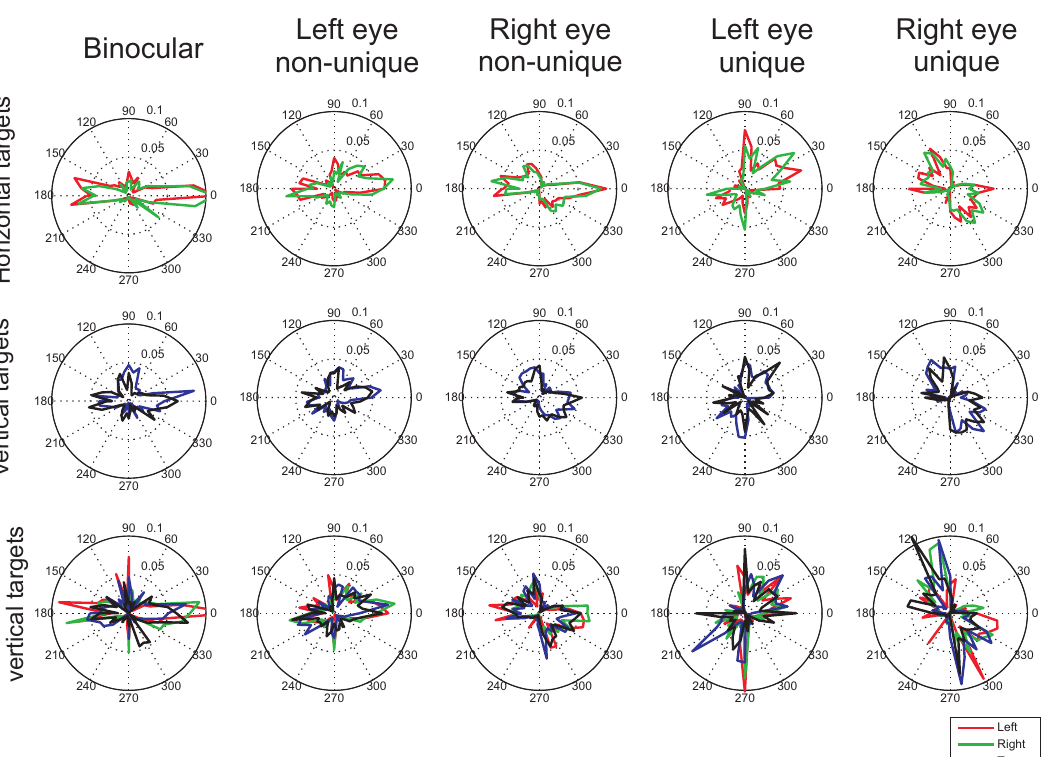
Figure 5 . Histograms of microsaccade directions after cue onset (from 0ms to 1500ms after cue onset), during which partic- ipants were presented with the arrow cue. The histograms (of proportions of microsaccades) were constructed by taking the average across the histograms for each participant separately. The different colors show the different cue directions (left, right, up, down). Each of the rows present the histograms for the different target conditions (horizontal, vertical, and combined horizontal and vertical targets). The leftmost column shows binocular microsaccades, the next two columns show histograms for monocular microsaccades that could also occur in the other eye at the same time. The rightmost two columns show the histograms for monocular microsaccades that occurred uniquely in one